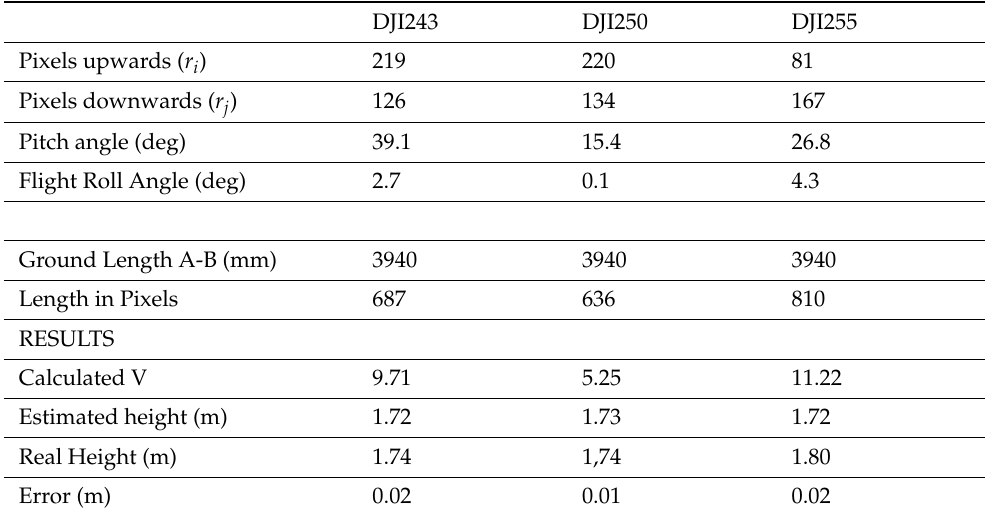
Table 5. Parameters related to the still image in Figure 8 and results of the analysis for the calculation of V and target height.